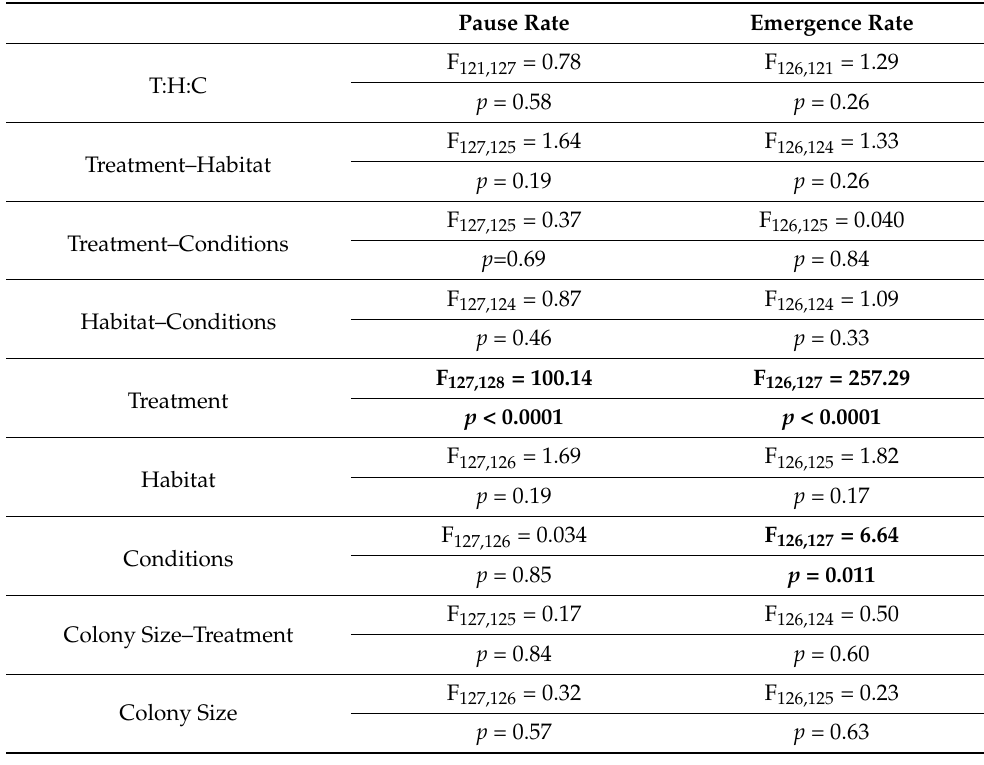
Table 3. Summary of statistical analyses on larvae testing the effects of hibernation conditions (lab and field), type of habitat (city and forest), and treatment (control or cadmium) for larval pause development rate and emergence rate. T:H:C means treatment–habitat–conditions triple interaction. Bold number indicates significant p